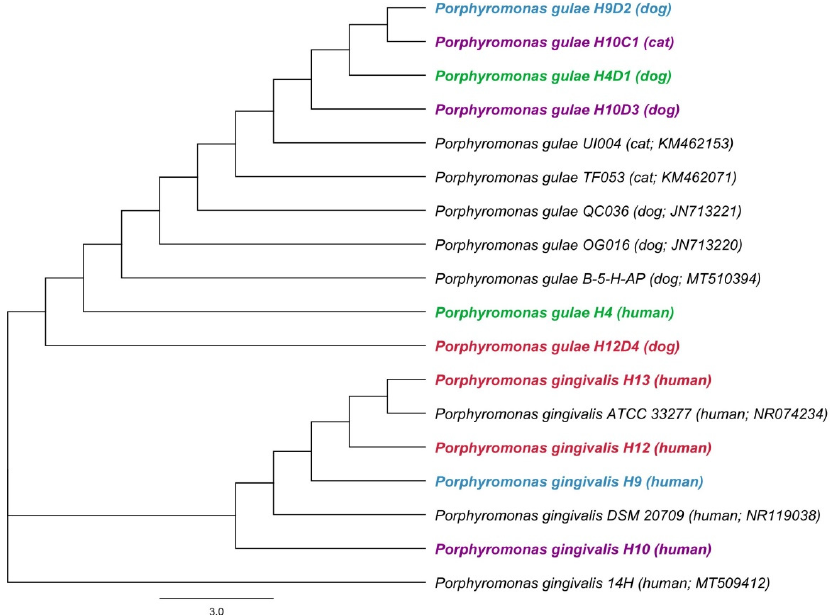
Figure 1. The phylogenetic tree of Porphyromonas gingivalis and Porphyromonas gulae based on 16S rRNA gene sequences. A phylogenetic tree for sequences obtained using primers for P. gingivalis was constructed by the neighbor-joining method. Length of 16S rRNA gene sequence used to construct the phylogenetic tree was 240 bp. Hosts and accession numbers for 16S rRNA gene sequences obtained from the GenBank database are given in parentheses. Each color represents the owners and their animals. T. forsythia from companion animals to their owners has not been proven.